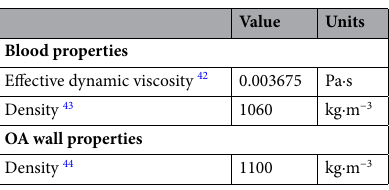
Table 4. Basic parameters of blood and wall of the ophthalmic